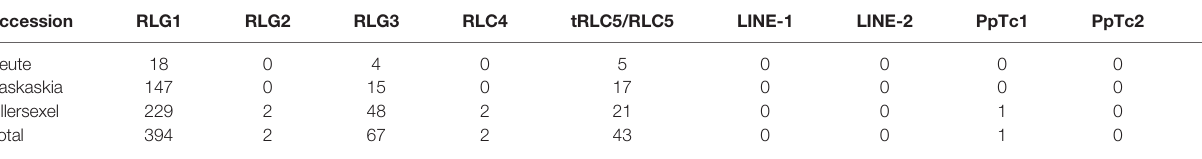
TABLE 2 | TE polymorphisms in the different P. patens accessions.